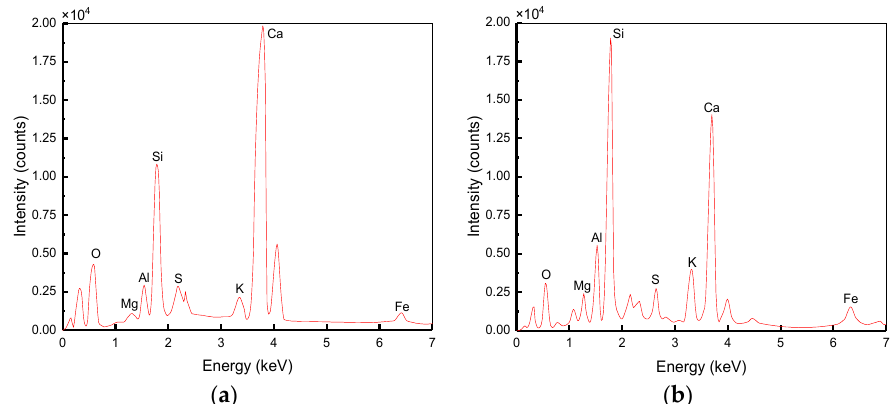
( b ) Figure 23. Interface between mortar and fibers: ( a ) Interface between mortar and BF of BC; ( b ) Interface between mortar and SF of SC. 5.3. Energy Spectrum Analysis The formation of ITZ is because of the gradient of w/c ratio caused by the penetration of water from mortar to aggregates surface and the thickness of ITZ is between 5 and 100 μ m [49]. Three specimens were prepared for each condition and the average value were obtained. Figure 24 shows the difference in the energy spectrum of PC between ITZ and CM. The atomic percentage of different elements is tabulated in Table 8. it presents that the contents of both Ca and O are the highest in the ITZ and CM. However, the content of Si in the CM is higher than that in the ITZ. Ca/Si of ITZ is 4.25